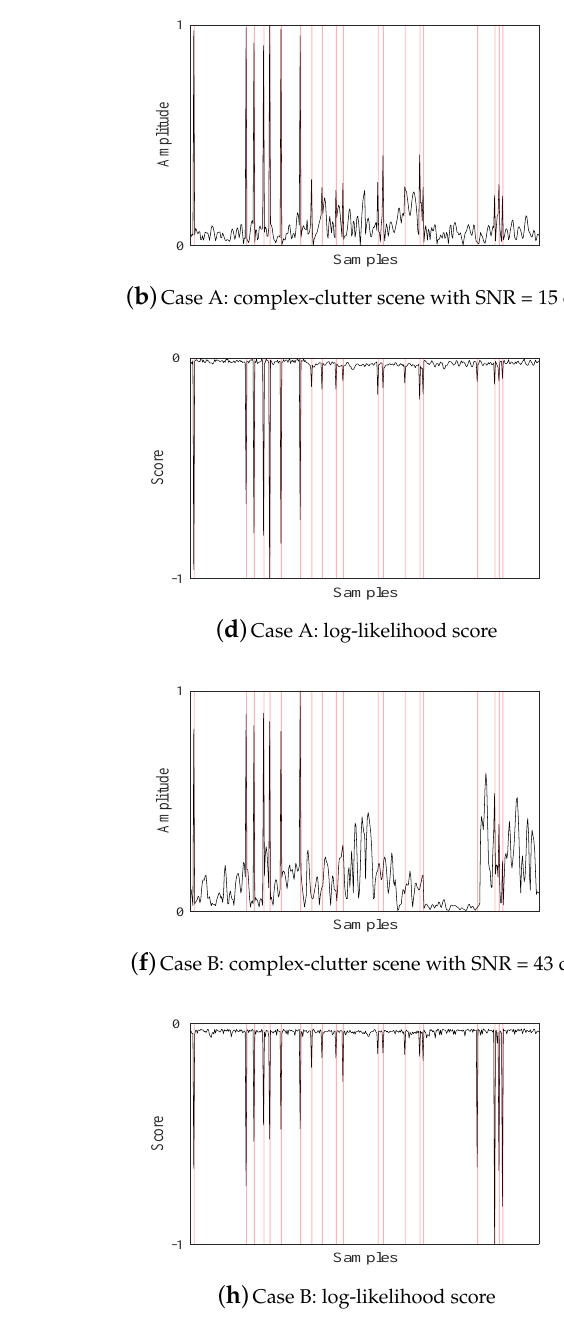
Figure 16. ( a – h ) Case study of reconstruction score on test datasets with different SNR. Regions highlighted in red represent the ground-truth target. Case A denotes data pre-processing with MTI or AMTI and case B indicates data pre-processing without MTI or